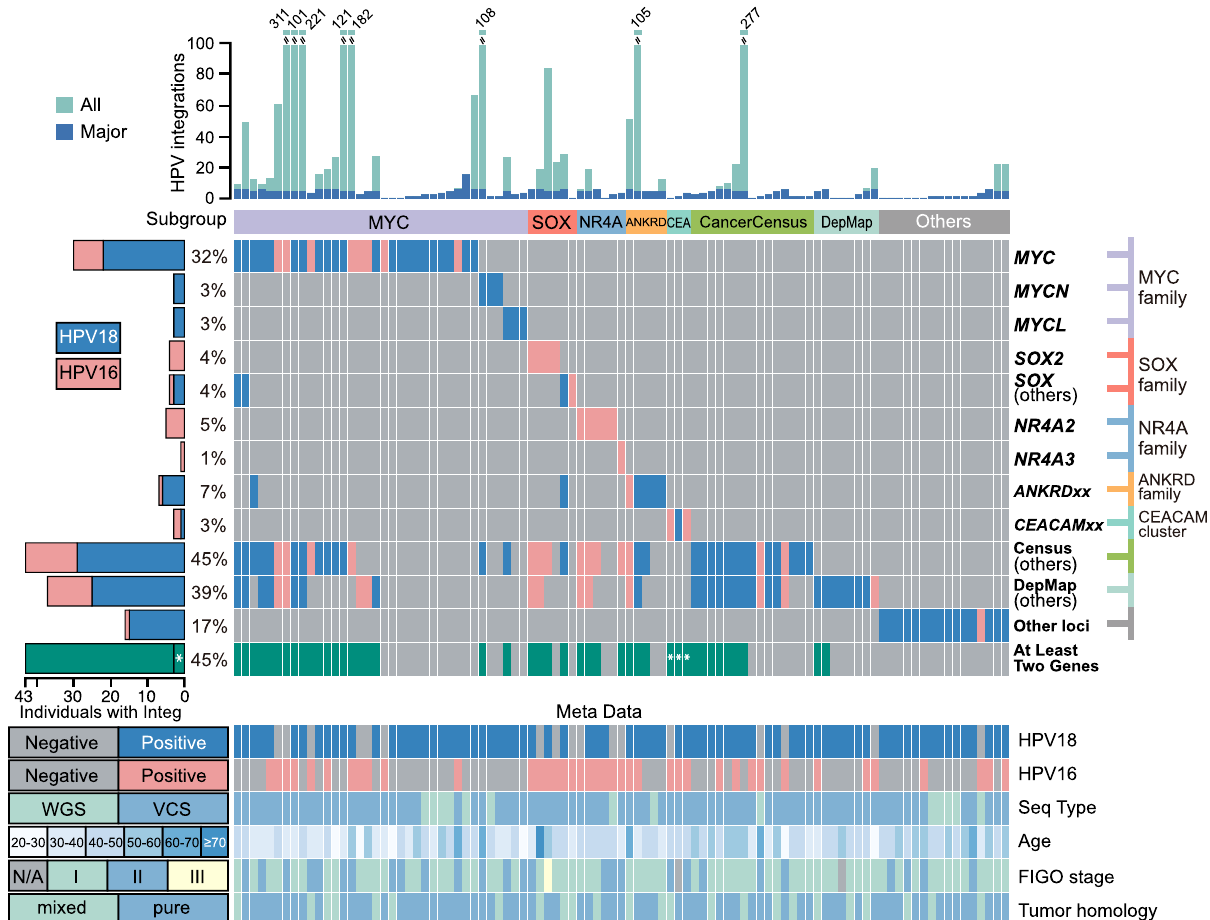
Fig. 1 | SCCC subtypes annotated by HPV-integrated hotspot genes. Hotspot gene families and groups that underwent major HPV integrations in 95 SCCC samples(81VCSand14WGS)aredisplayed.Samplesubgroupsareannotatedbased on the mutually exclusive patterns of HPV-integrated genes. SOX (others) means genes except for SOX2 in the SOX family. CancerCensus (others) and